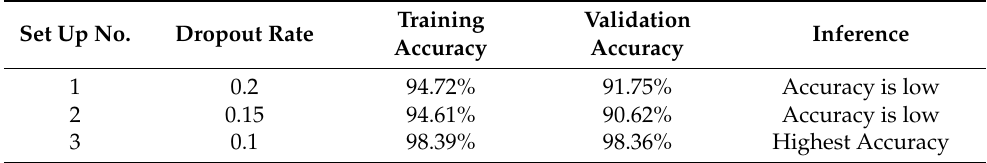
Table 12. Results of ablation study 3, varying the dropout value. Set Up No.